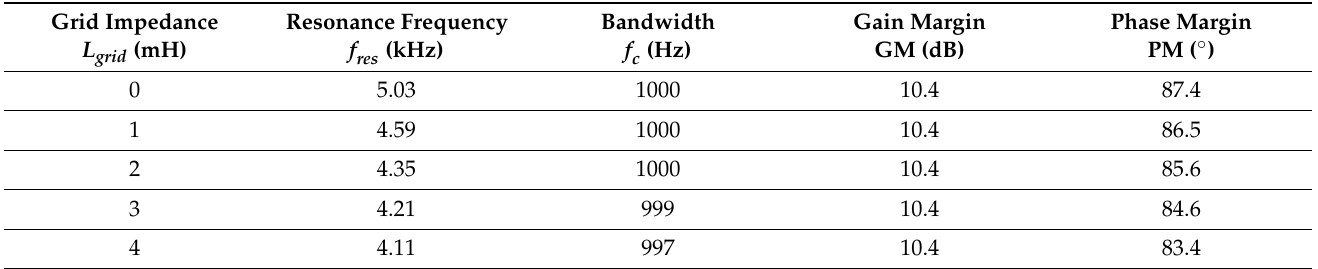
Table 7. Stability Analysis with the Proposed RESO Based ADRC for the LCL Filter Type GcI. Grid